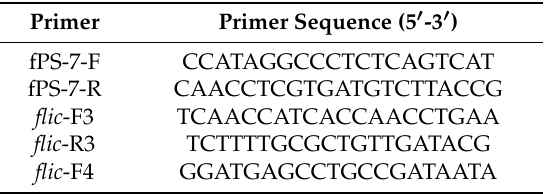
Table 3. The primers used in this